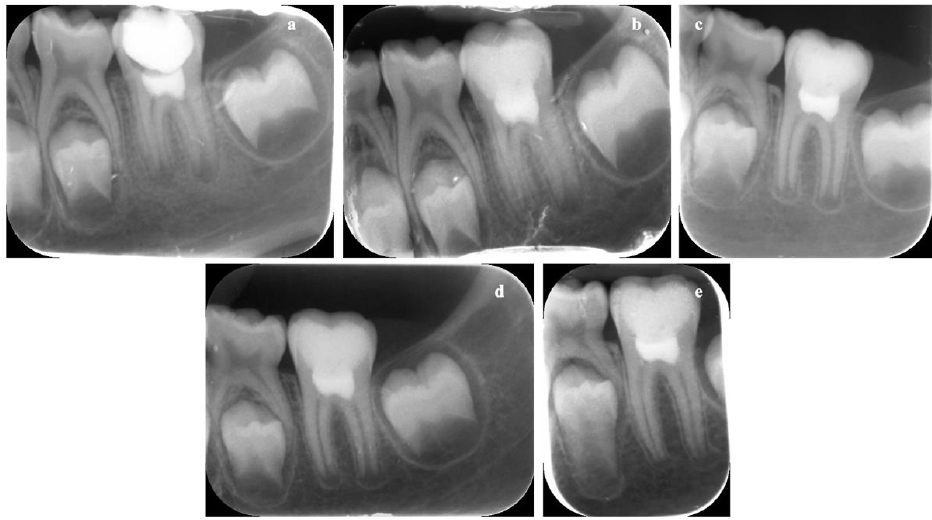
Figure 11. Periapical radiographs of dental element (3.6) treated with ProRoot MTA. The immature permanent tooth is shown immediately after vital pulp therapy (Baseline) ( a ) and after 1 month ( b ), 3 months ( c ), and 1 ( d ) and 2 years of follow-up ( e ). Progressive formation of the dental roots could be observed over time. Closure of apical foramina is clearly represented after 2 years of follow-up.